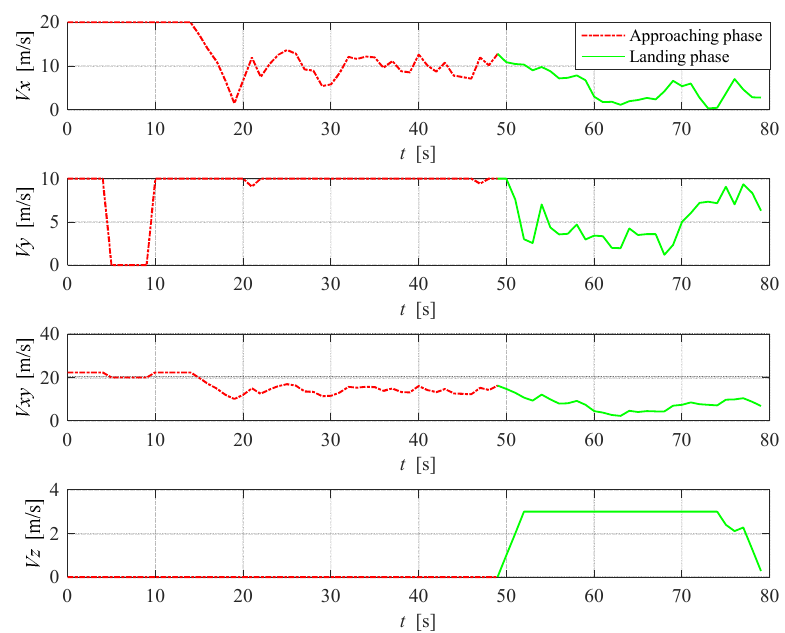
Figure 7. Velocity of the helicopter during the landing task.